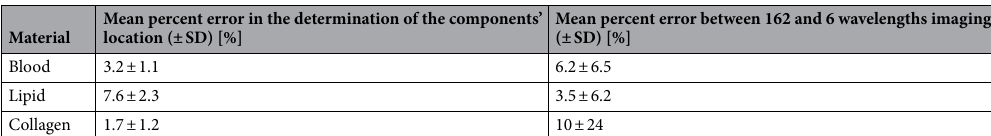
Table 1. Error estimation in phantom measurements. First column is the mean percent error for each channel’s area between the MSPAI prediction and the channel’s area calculated with US. The second column is the mean percent error in proportion determination between 162 and 6 wavelengths inside the channels